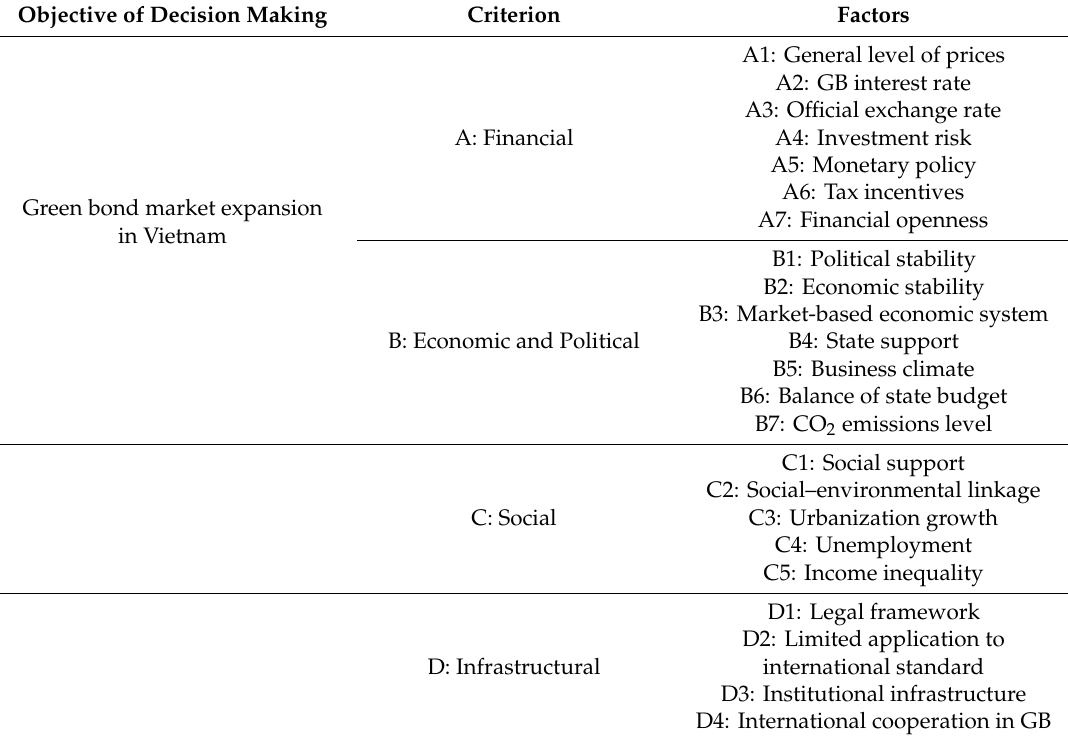
Table 3. Network structure of our model. GB, green bond.